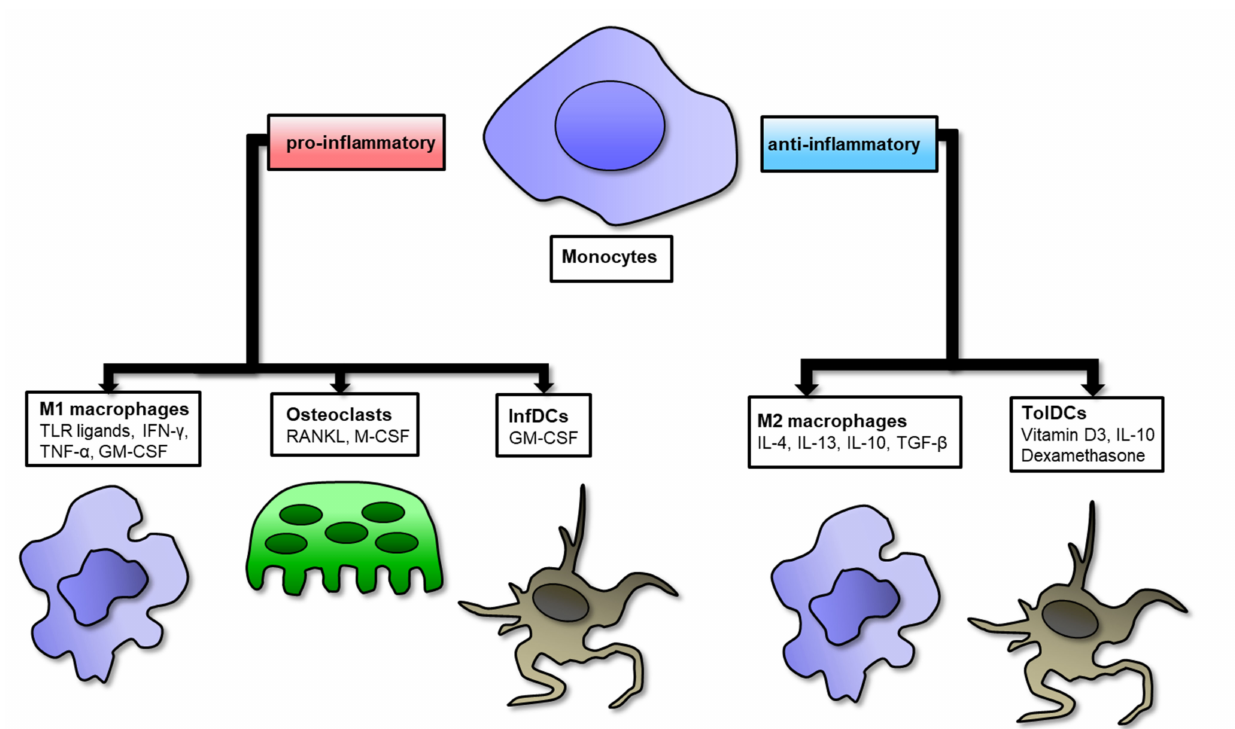
Figure 1. Schematic representation of macrophage polarization and its various stimuli differentiating toward pro- or anti- inflammatory phenotypes in RA. On the left side, monocytes can differentiate toward pro-inflammatory M1 macrophages, osteoclasts and inflammatory DCs (InfDCs); on the right side, monocytes can differentiate toward anti-inflammatory M2 macrophages and tolerogenic DCs